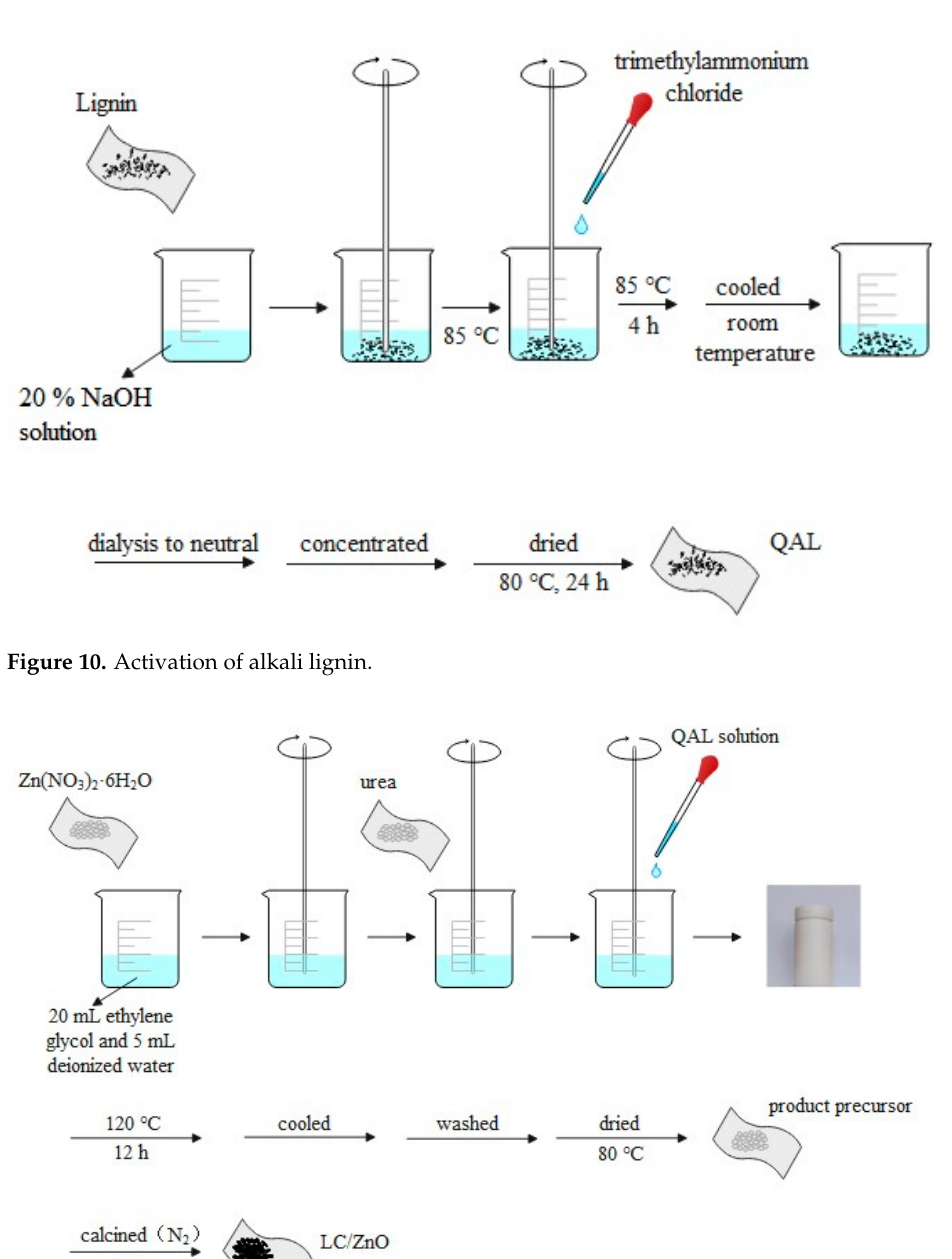
Figure 10. Activation of alkali lignin.